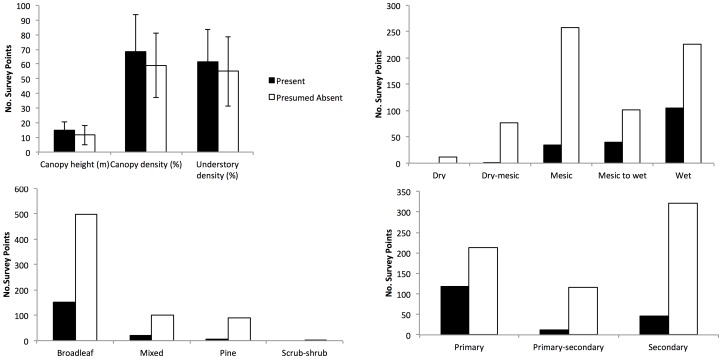
Ocular estimates of canopy height (m; mean±SD ), understory and canopy density (% cover; mean±SD), and the frequency of forest type, seral stage, and moisture regime at presence/presumed absence survey points for Bicknell’s Thrush in the Dominican Republic.